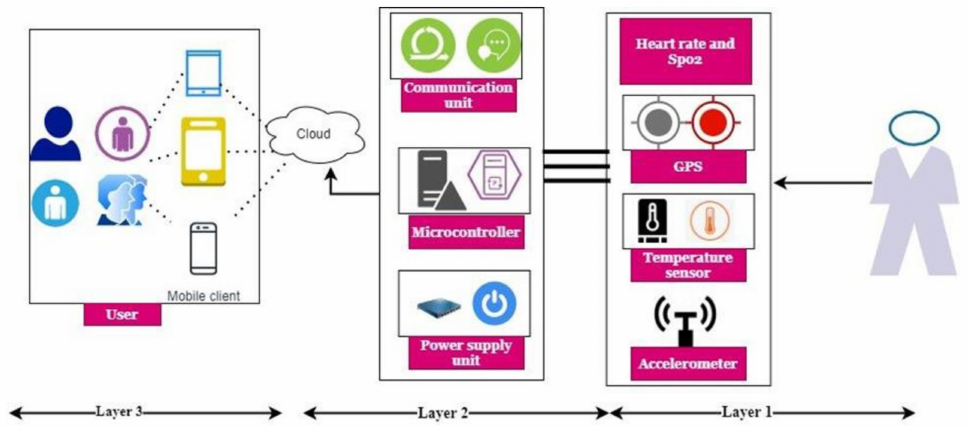
Figure 2. Three-layer design of COVID-19-patient health-monitoring